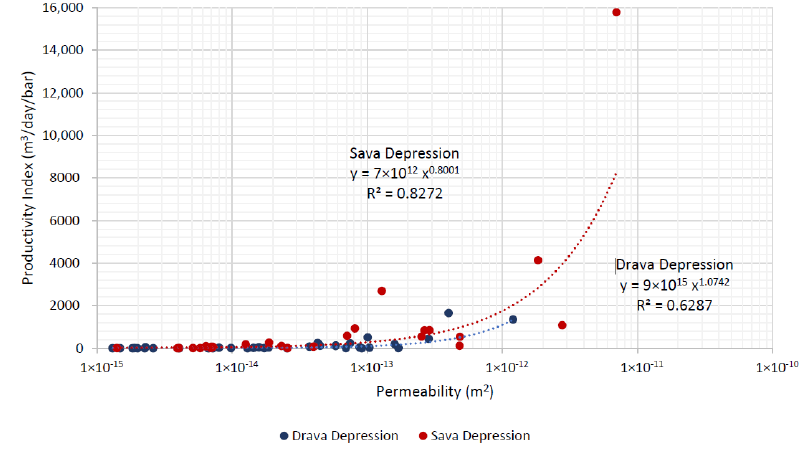
Figure 4. Productivity index vs. permeability data correlation—syn-rift phase.